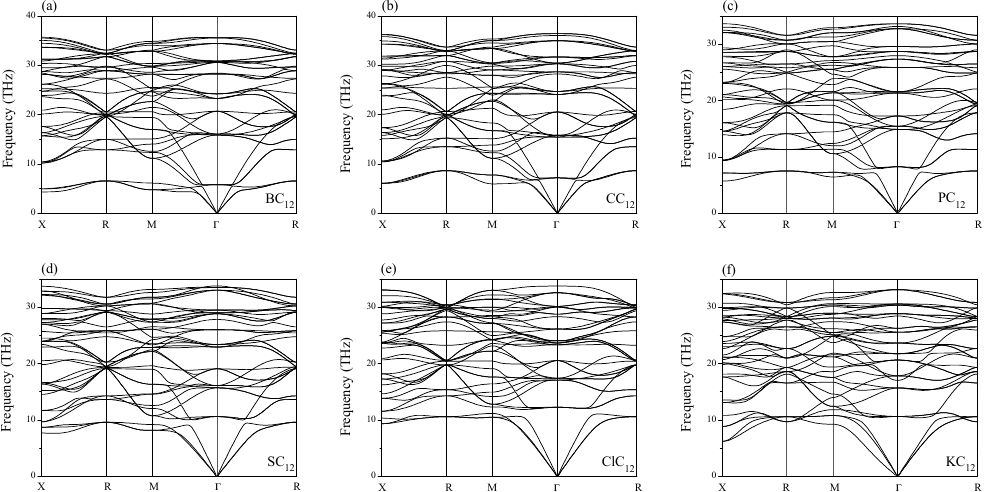
Figure 3. Phonon spectra of dynamically stable phases ( a ) BC 12 ; ( b ) CC 12 ; ( c ) PC 12 ; ( d ) SC 12 ; ( e ) ClC 12 ; and ( f ) KC 12 .